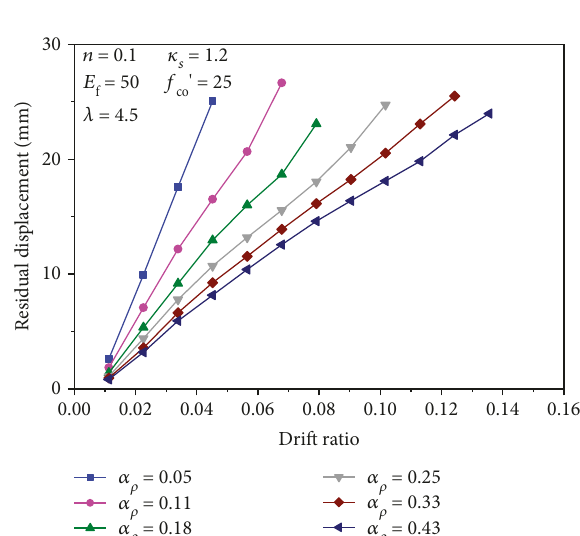
k ff erent parameters. 1 and 2 with di